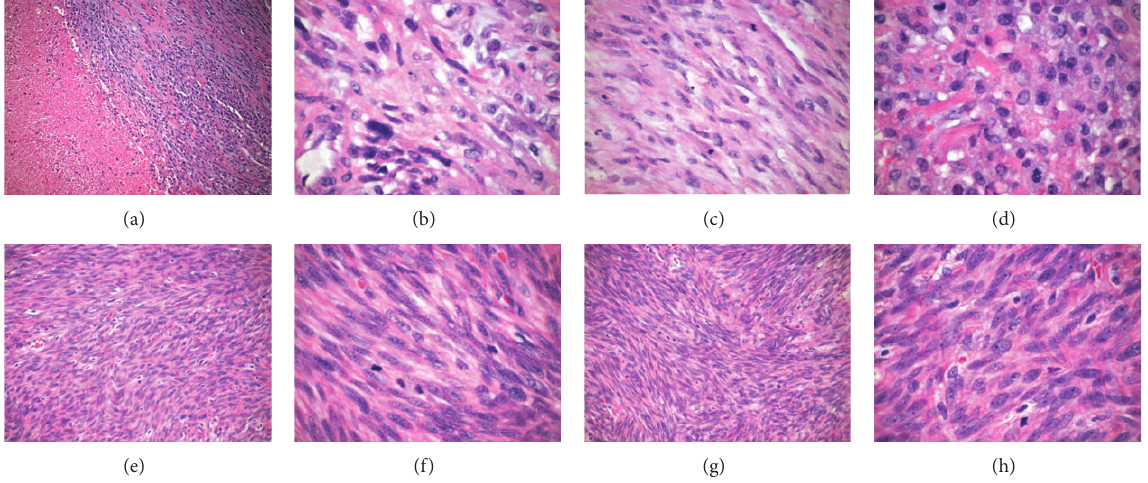
Figure 2: Histology. ((a)–(d)) Uterus: (a) hypercellularity with geographic necrosis (100x), (b) cellular atypia (600x), and ((c) and (d)) mitotic figures (400x). ((e)-(f)) Left Ovary. Cellular atypia and mitoses ((e) 200x and (f) 600x). ((g)-(h)) Right ovary. Cellular atypia and mitoses ((g) 200x and (h)